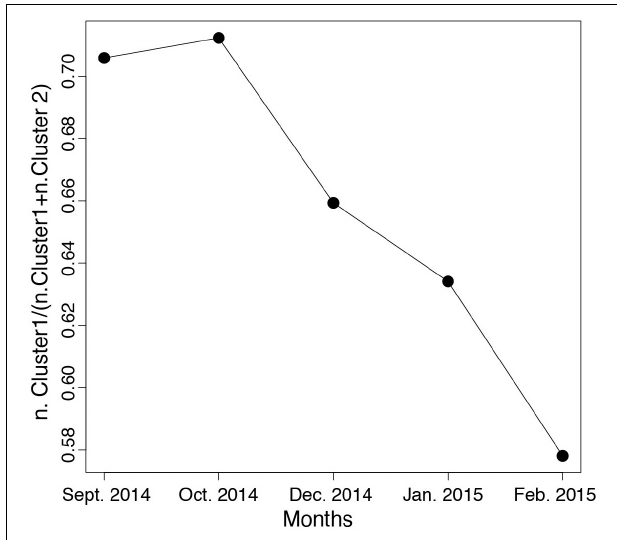
FIGURE 11 | Evolution of the fraction of Cluster 1 relative to Cluster 2. Note that we did not have samples from November 2014.